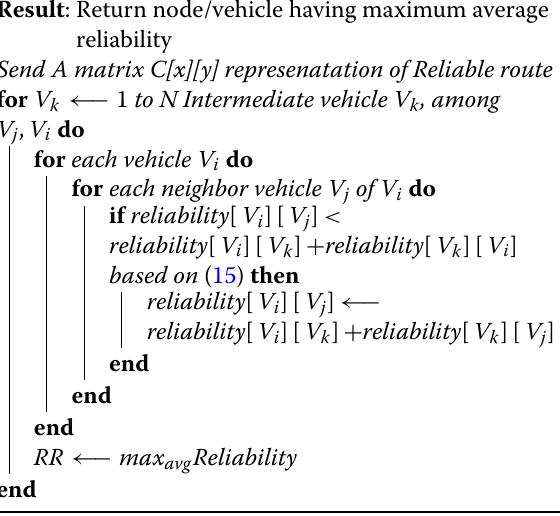
Algorithm 1: Reliable route (RR)